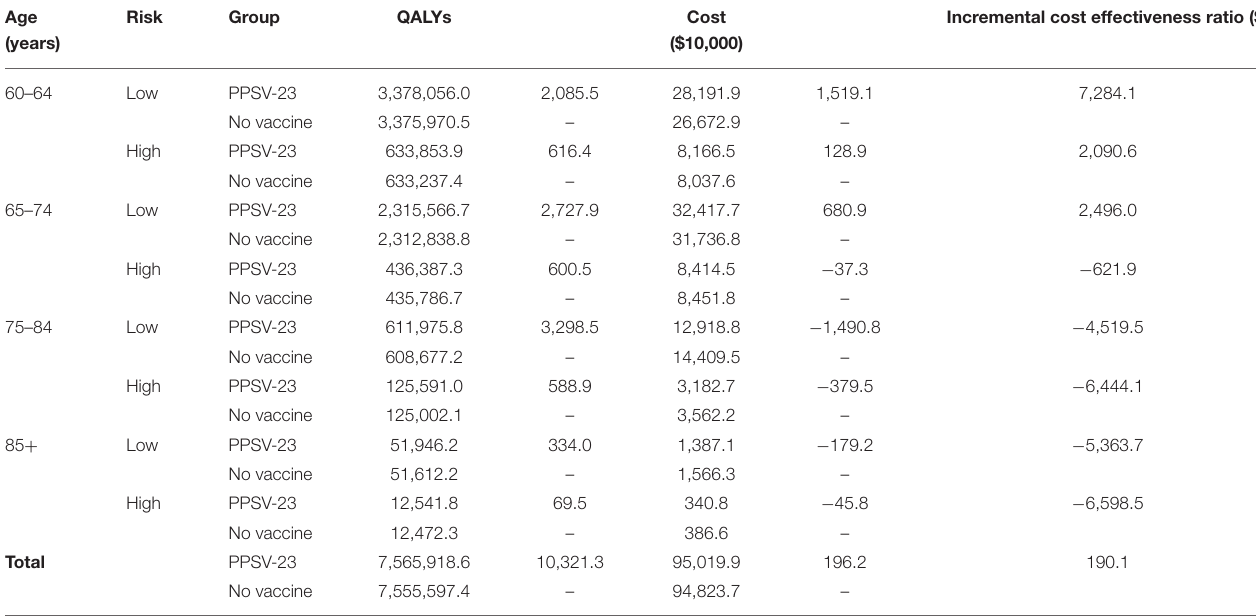
TABLE 2 | Cost, QALYs and ICER in base case